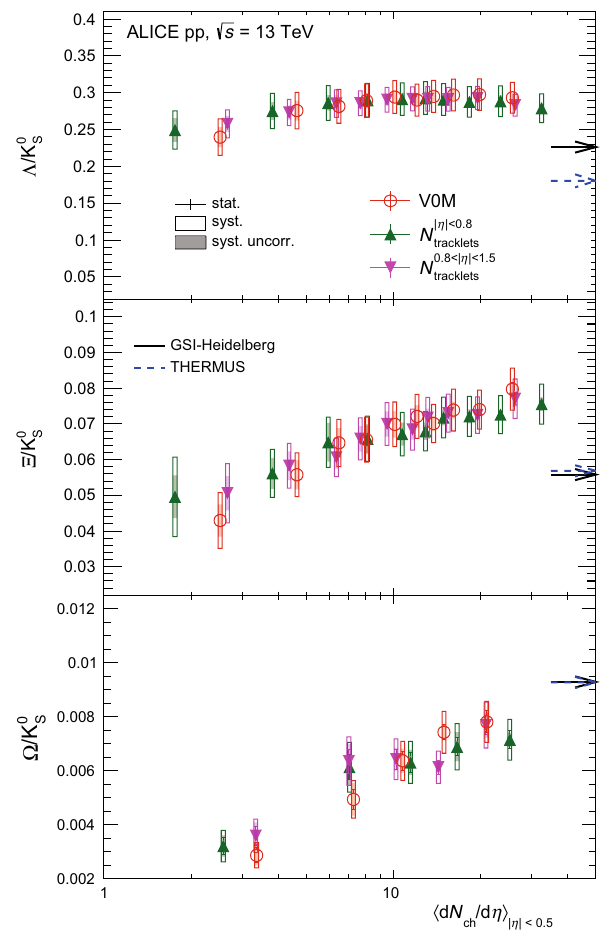
Fig. 13 Ratios of integrated yields of (cid:3) (no (cid:3) contribution considered here), (cid:4) ,and (cid:5) toK 0 asafunctionofd N ch / d η fordifferentmultiplicity √ S s = 13 TeV. Sta- estimators (see text for details) in pp collisions at tistical and systematic uncertainties are shown by error bars and empty boxes, respectively. Shadowed boxes represent uncertainties uncorre- lated across multiplicity. The corresponding calculations from grand- canonical thermal models, which refer to most central Pb-Pb collisions √ s NN = 2 . 76 TeV, are at